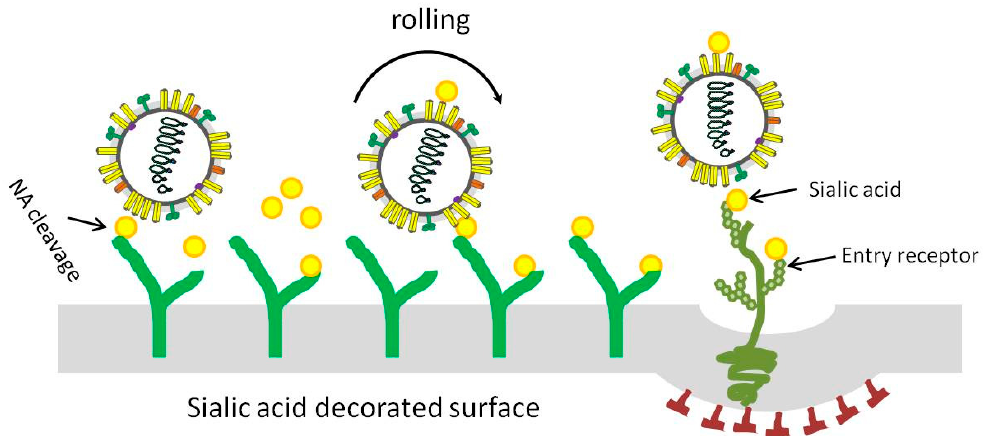
Figure 2. Representative model for influenza A virus moving on sialic acid (SA) decorated surface. In order to infect a target host cell, the virus might need to move either across airway mucus to reach the target cell or on the cell surface to access an entry receptor. After viral attachment, the NA could degrade SAs near the attachment site, resulting in reduced SA density; the SA density gradient promotes virus moving until successful infection